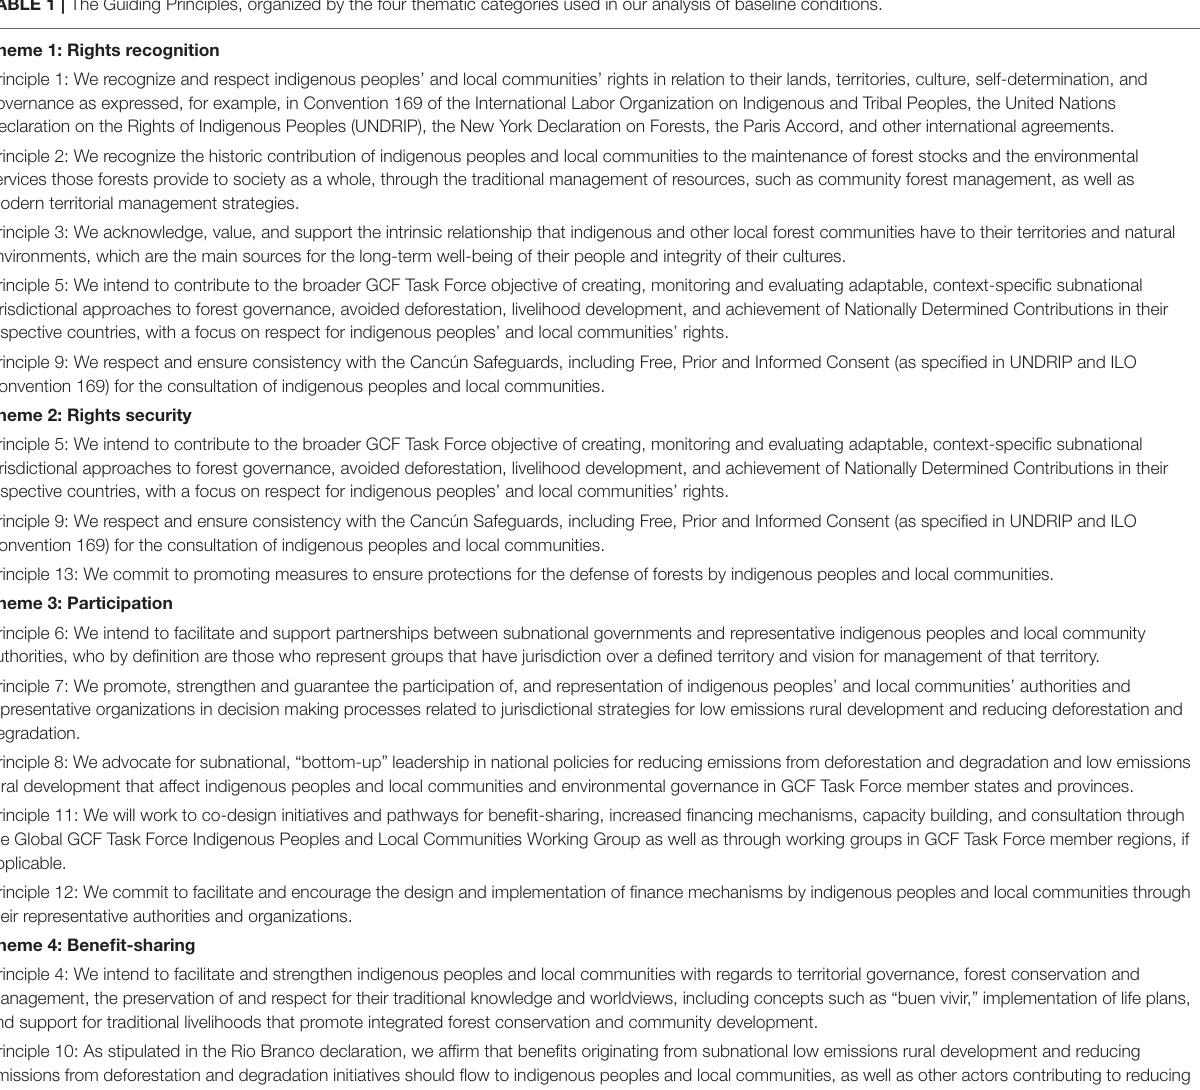
figure prominently in the Principles. Climate change mitigation became more broadly considered a human rights issue in the early 2000s, with the UNFCCC expanding references to IP